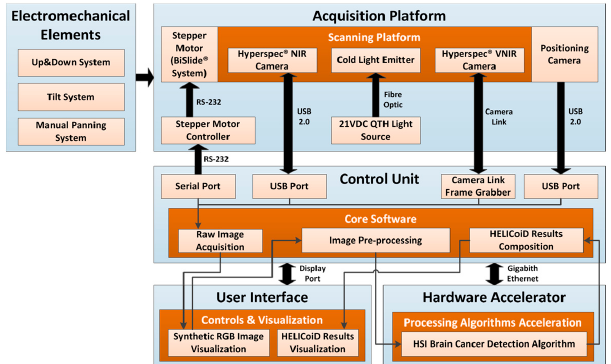
Figure 1. The HELICoiD demonstrator block diagram. QTH: Quartz Tungsten Halogen.